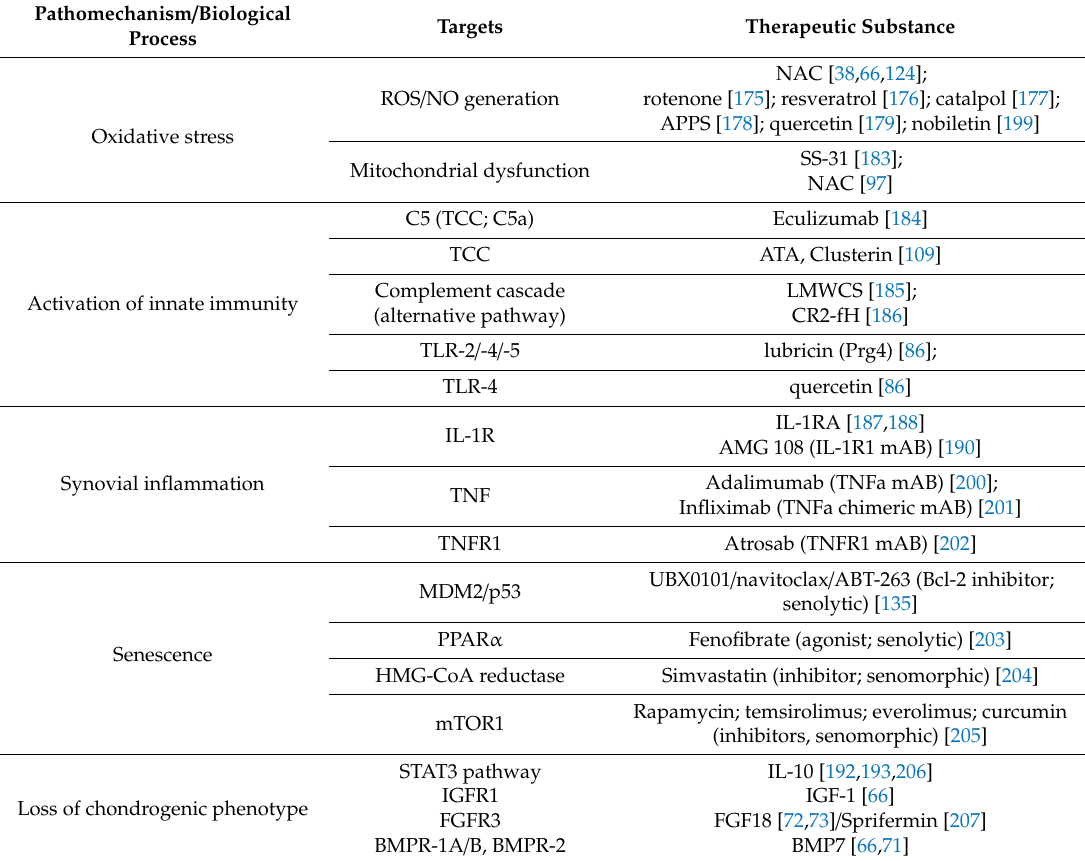
Overview of potential targets in the pathogenesis of PTOA and corresponding therapeutic